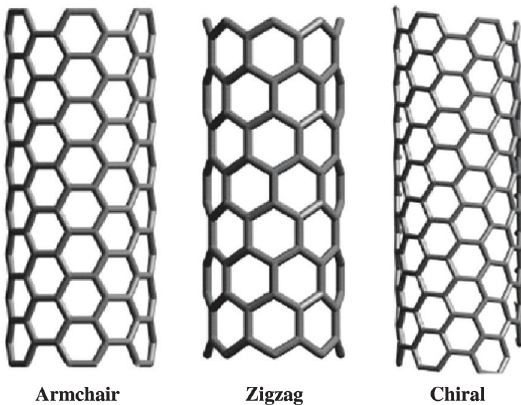
Figure 2. Different types of CNT 16 .